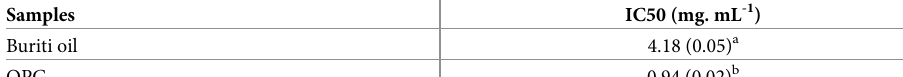
OPG: Buriti oil nanoencapsulated in a porcine gelatin. Mean and standard deviation (SD), n = 3. The different lowercase letters indicate a statistical